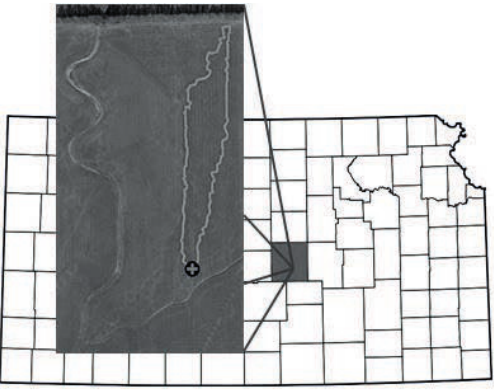
Fig. 1 The drainage area and headcut of the studied ephemeral gully in central